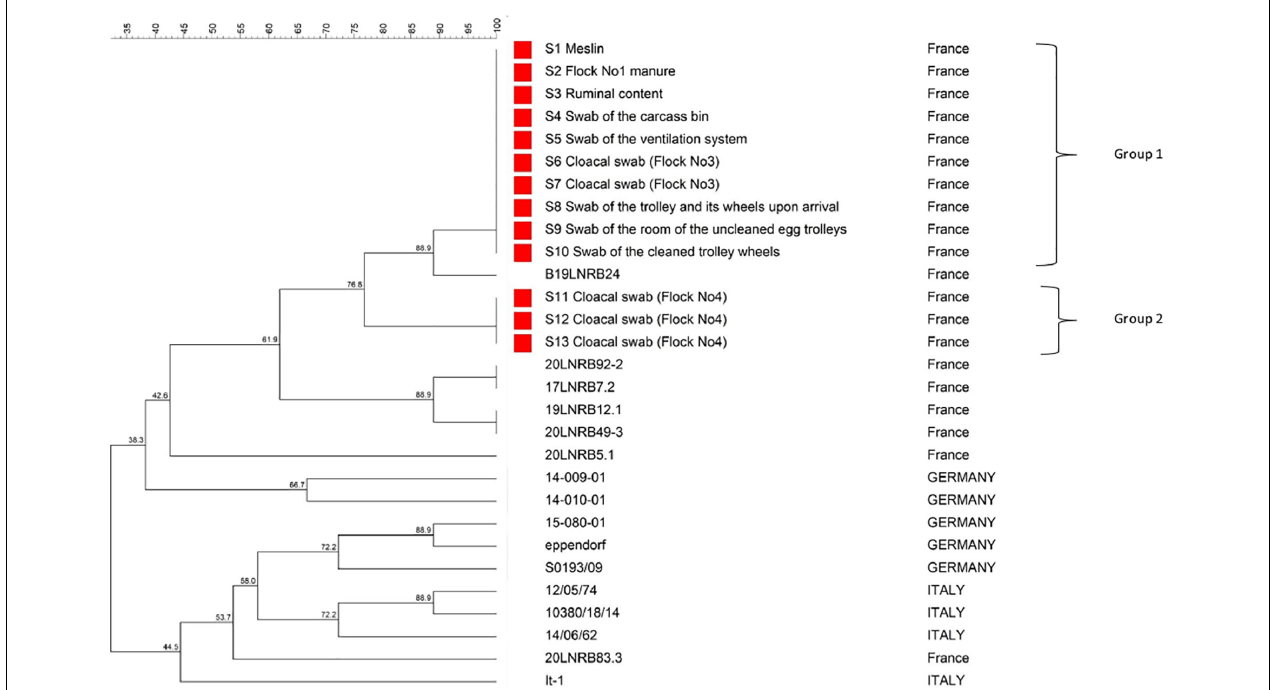
FIGURE 2 | Multilocus variable-number tandem repeat analysis (MLVA) dendrogram of 13 samples collected in this study and positive for C. botulinum type D/C (in red) and 16 other strains of C. botulinum type D/C (typed in other studies) constructed using the UPGMA method, implemented in BioNumerics. The name and code of samples from our study and names of strains from previous studies and their respective country are shown on the right. Samples S1–S13 were separated in 2 groups based on MLVA